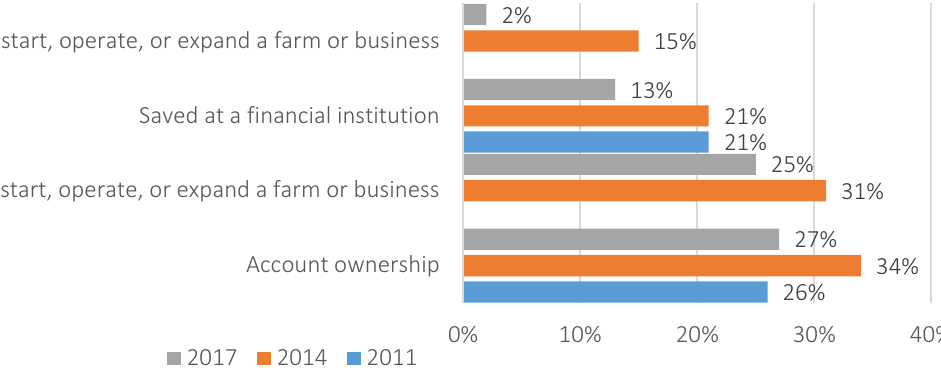
Figure 2. Some financial indices on the financial inclusion among women in